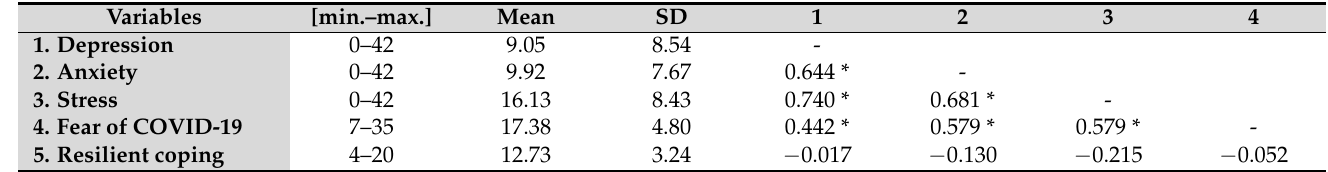
Table 3. Bivariate correlations among variables (n = 60).